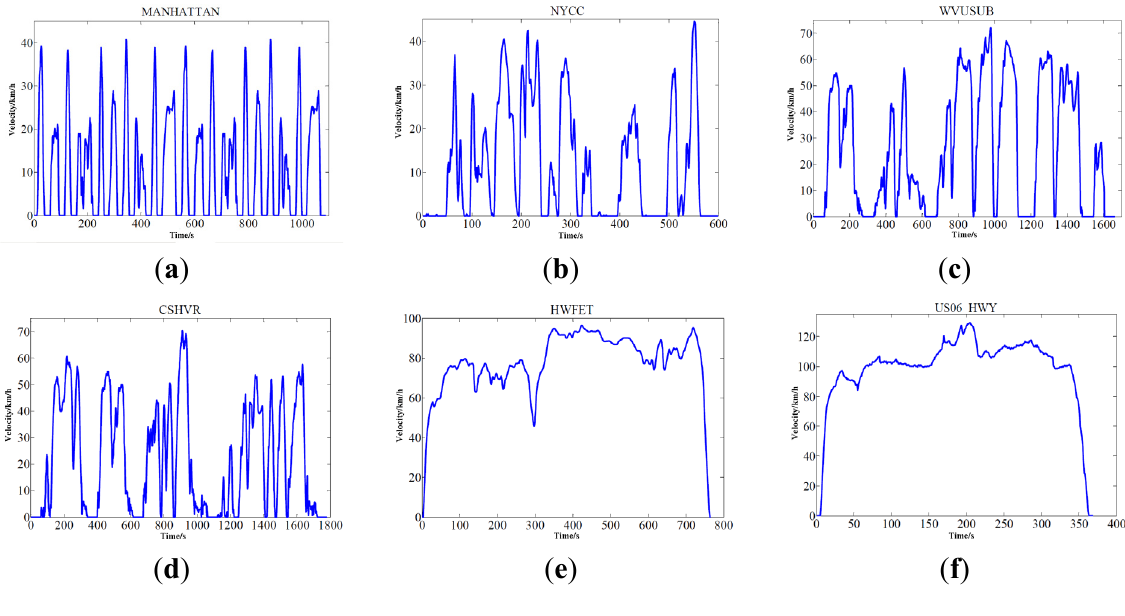
Figure 2. Velocity-time profiles of the six representative cycles; ( a )